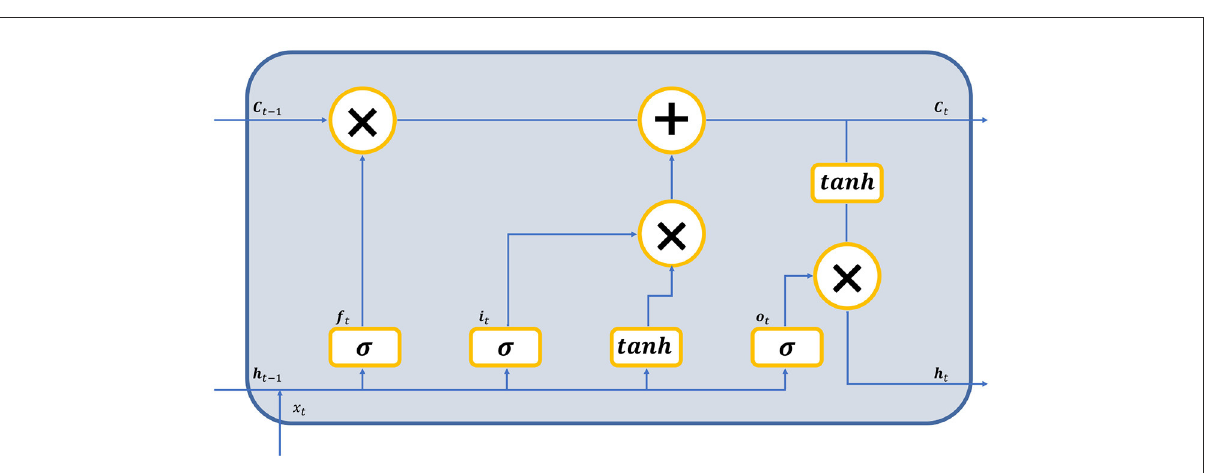
FIGURE2 The structure of the LSTM